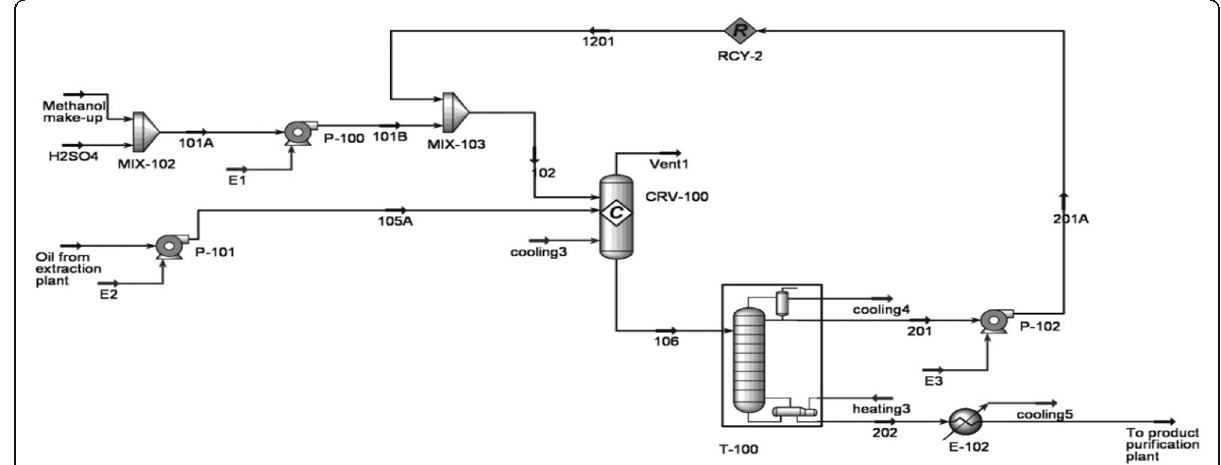
Fig. 4 Transesterification flow sheet, where (MIX-102) make-up alcohol/catalyst mixer, (MIX-103) recycled alcohol/catalyst and fresh alcohol mixer, (P-100) alcohol and catalyst pump, (P-101) oil pump, (P-102) recycled alcohol pump, (CRV-100) transesterification reactor, (T-100) methanol recovery distillation tower, and (E-102)